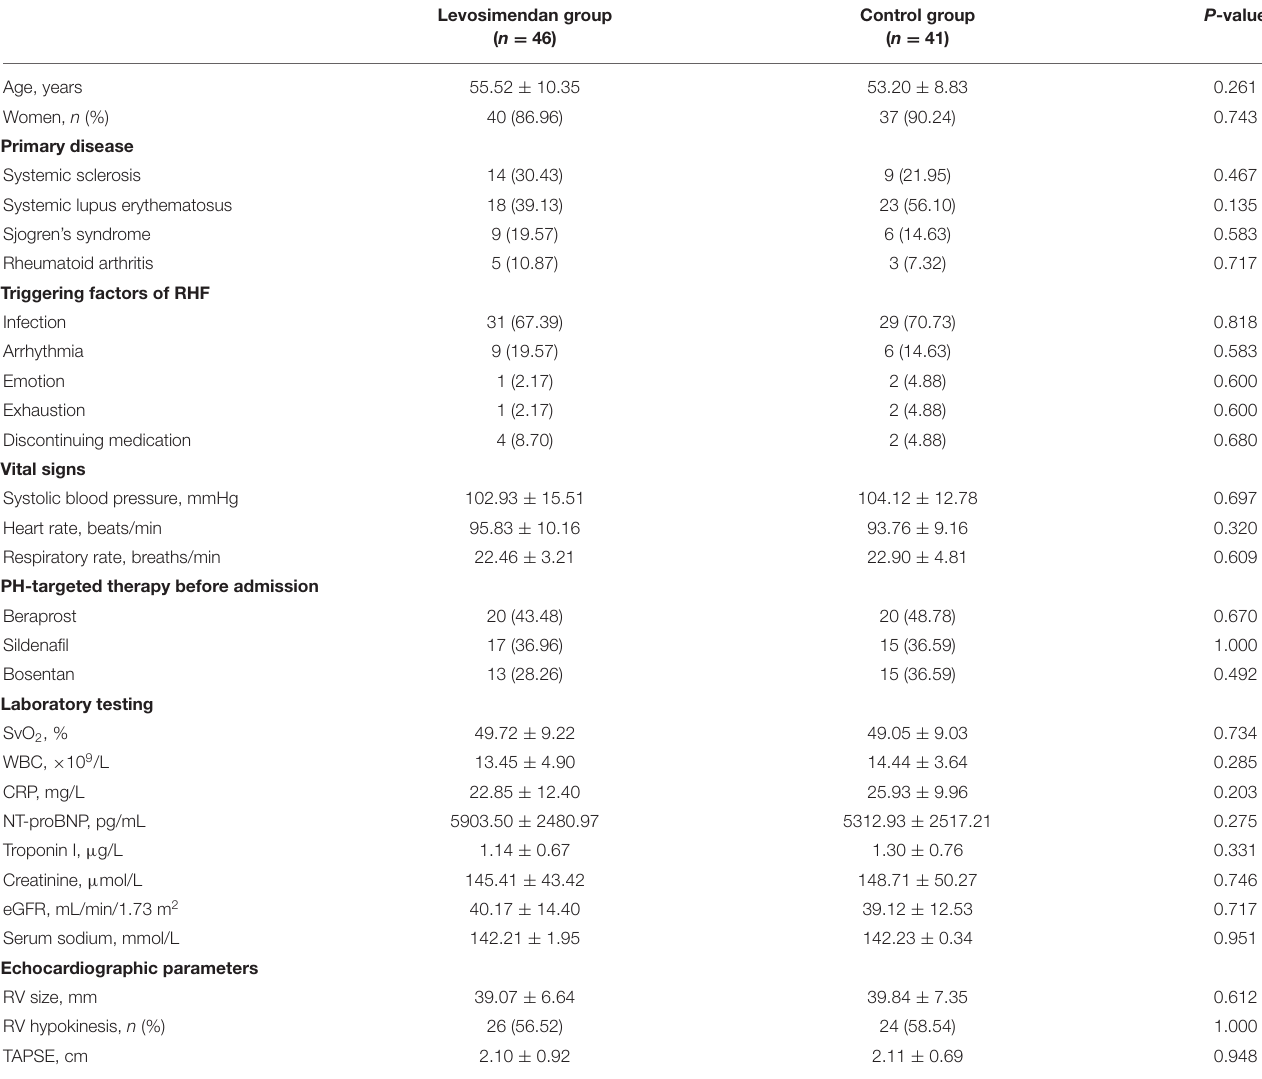
TABLE 1 | Baseline characteristics of patients hospitalized with acute decompensated right heart